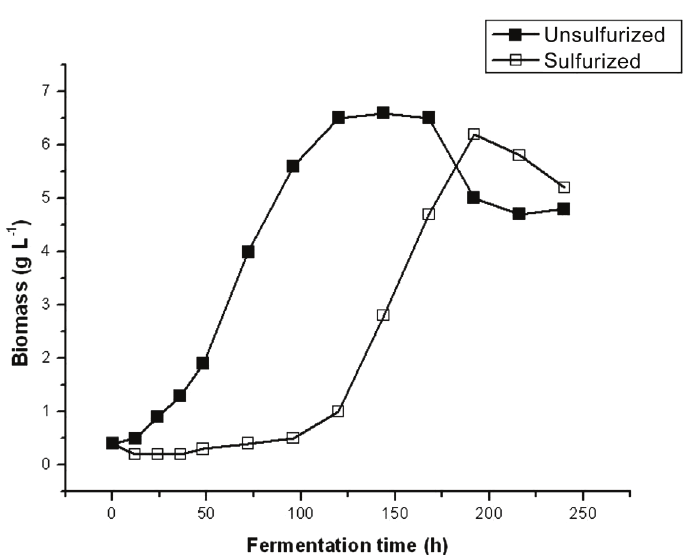
Fig. 1 – Growth of biomass of unsulfurized and sulfurized fermentation